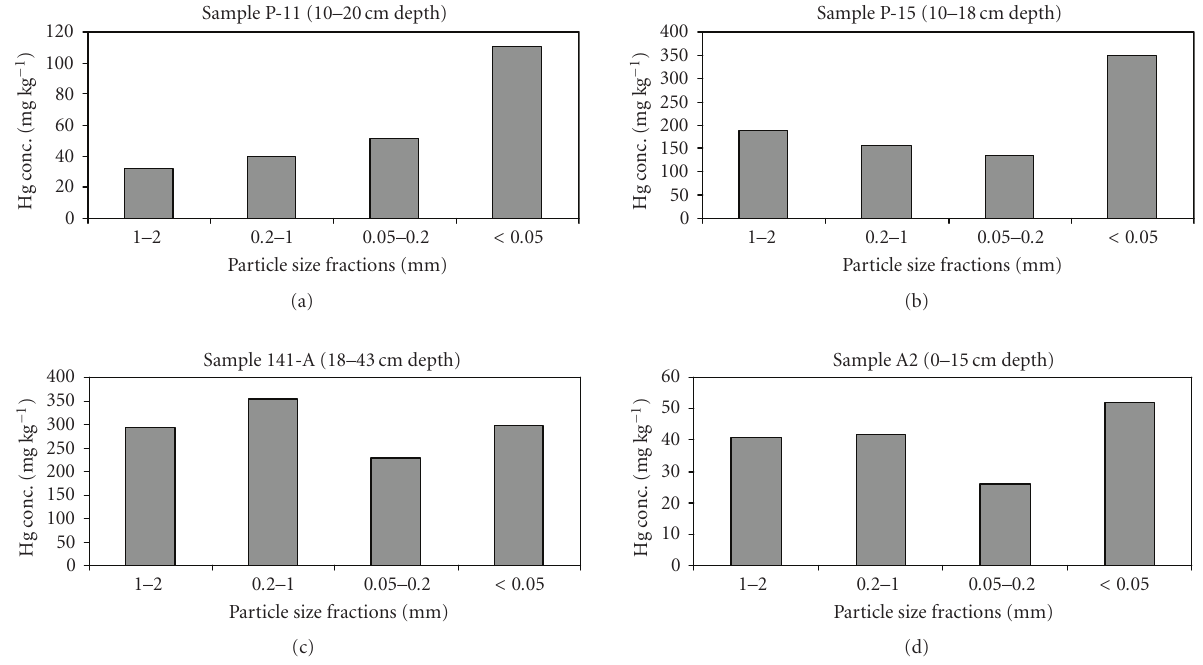
Figure 3: Concentration of Hg within the di ff erent particle-size subsamples of selected soil